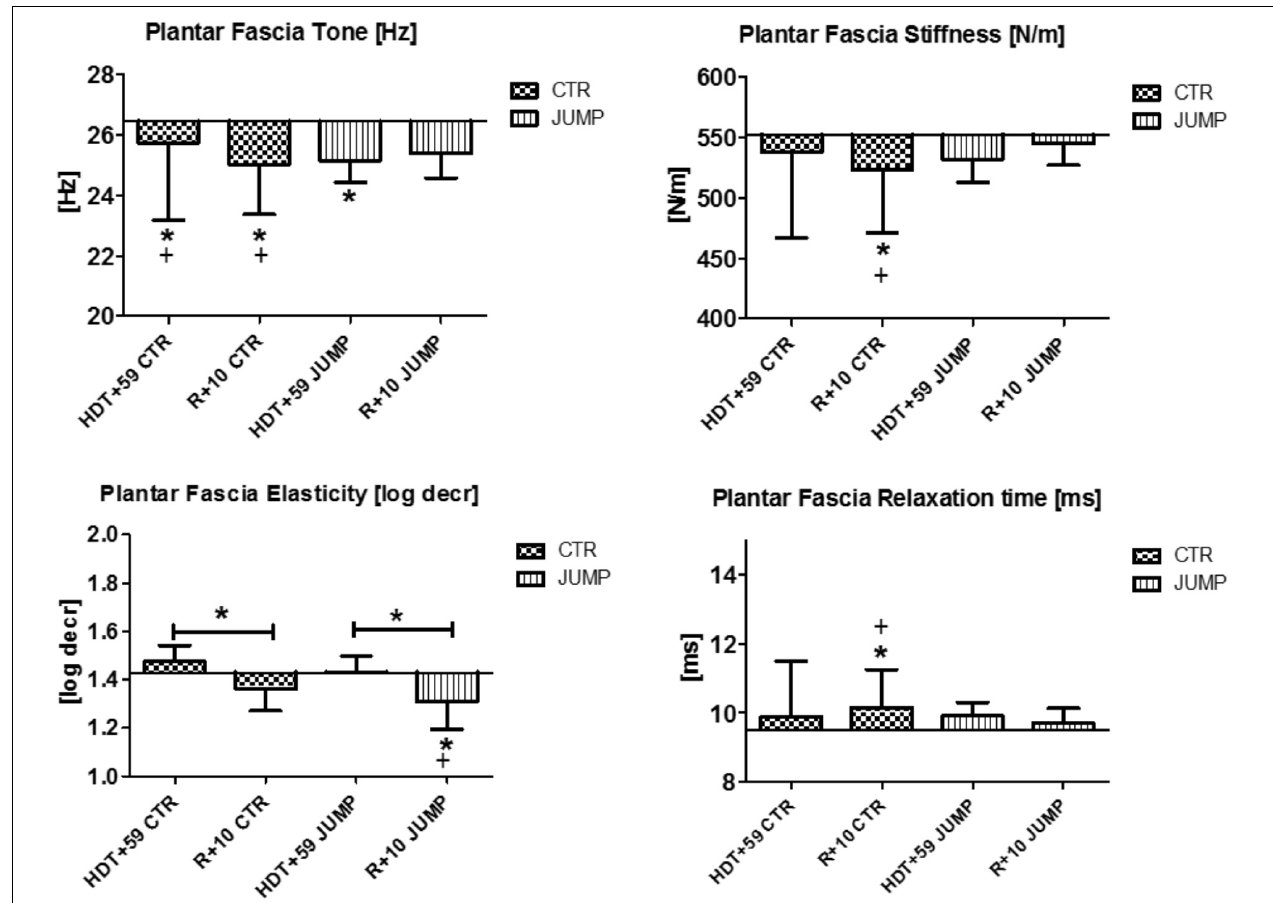
FIGURE 11 | Plantar fascia (MP21/22). Oscillation signal patterns in RSL bed rest study. ABD = Average baseline data (Tone HDT+1 = 26.44; Stiffness HDT+1 = 552.05; Elasticity HDT+1 = 1.43; Relaxation HDT+1 = 9.50). ∗ p < 0.05 ± SD, +Spearman ρ